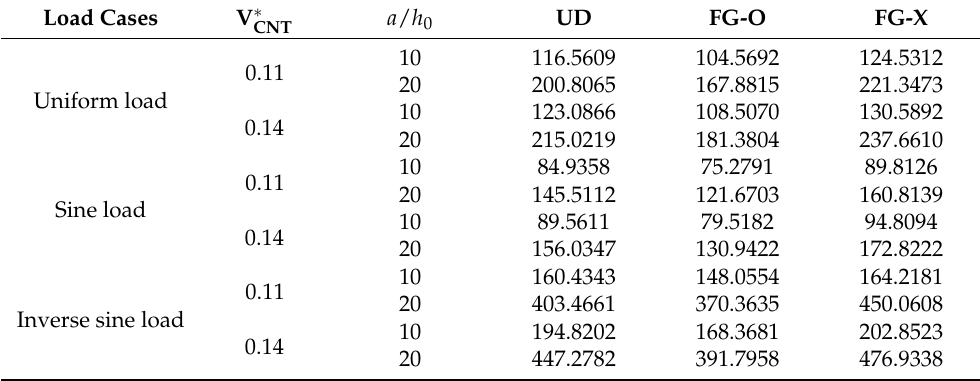
Table 6. The effects of the CNT distributions, CNT volume fractions, and length to thickness ratio on the variations of the dimensionless biaxial buckling load of the FG-CNTRC microplate under uniform and nonuniform edge loads